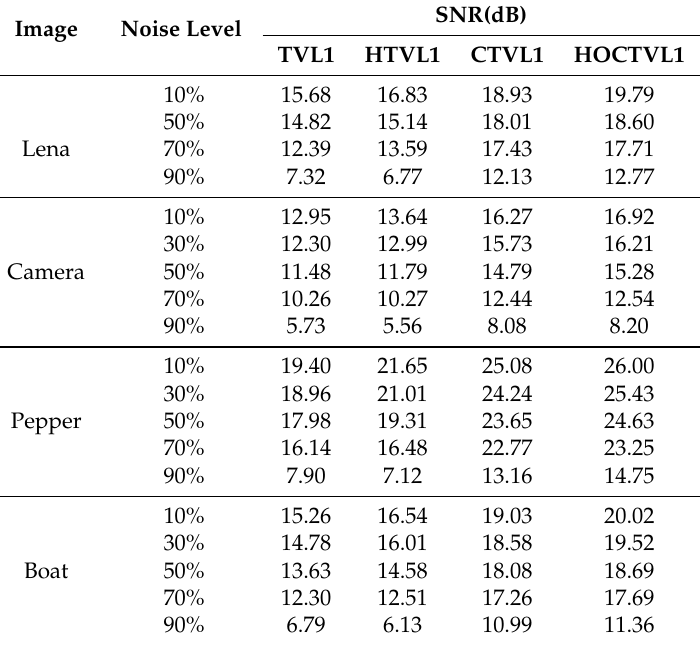
Table 1. SNR of four different models for test images corrupted by Gaussian blur and salt-and-pepper noise.